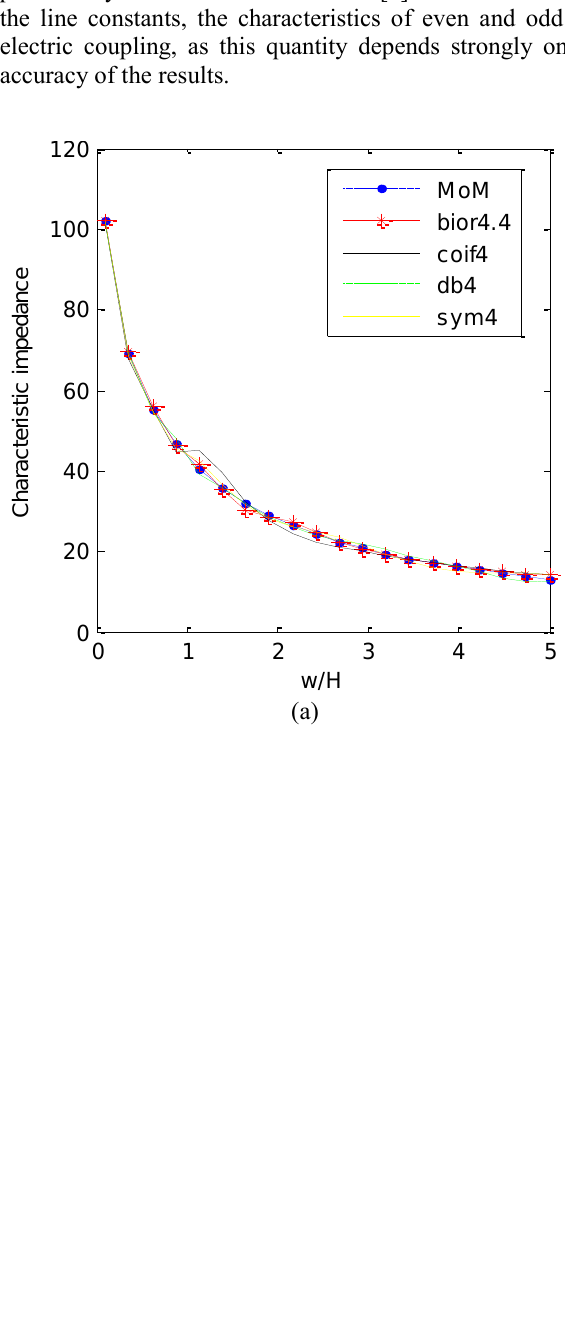
w1=w2=0.635, W/h = 0.005 to 1.5, and s=2 mm.